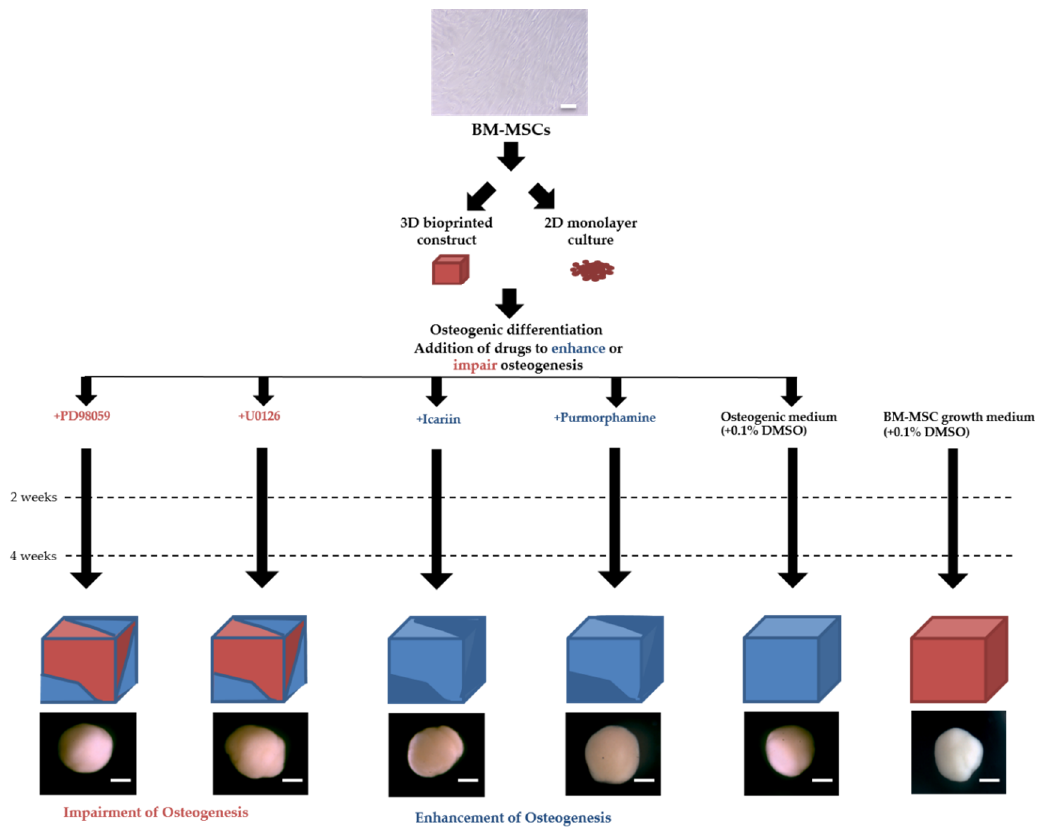
Figure 6. BM-MSC derived 3D bioprinted constructs and 2D monolayer cultures were cultured